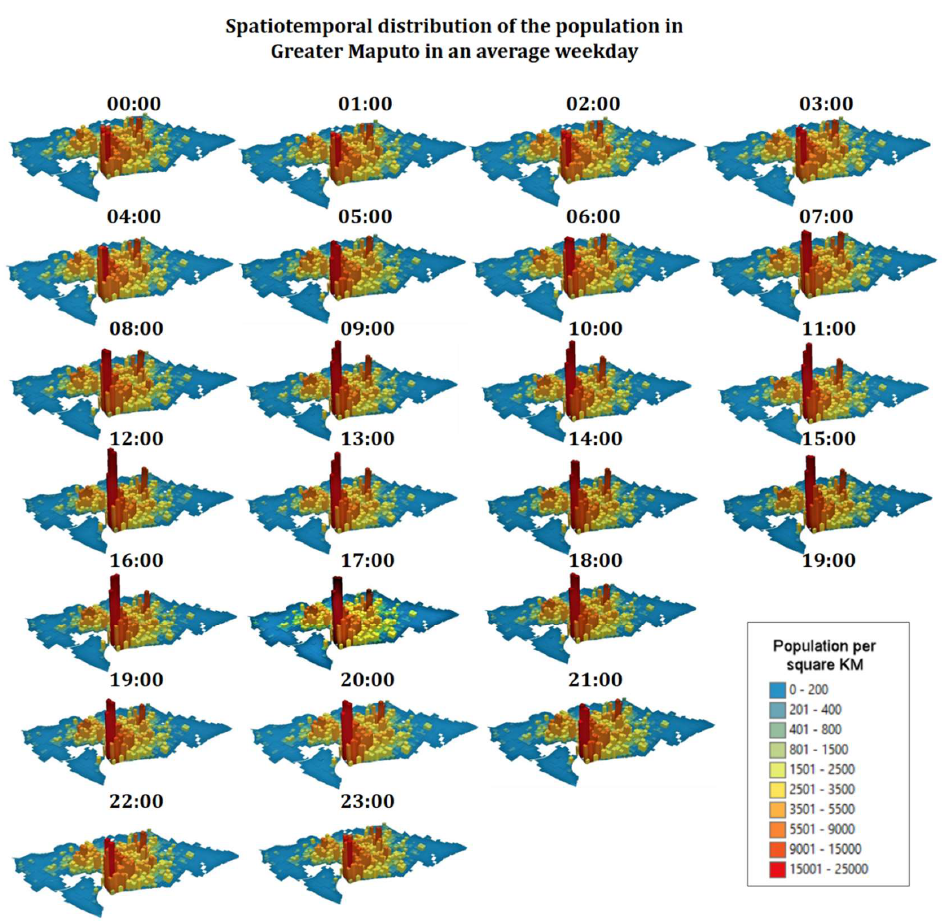
Figure 18. Spatiotemporal distribution of the population in Greater Maputo on an average weekday.